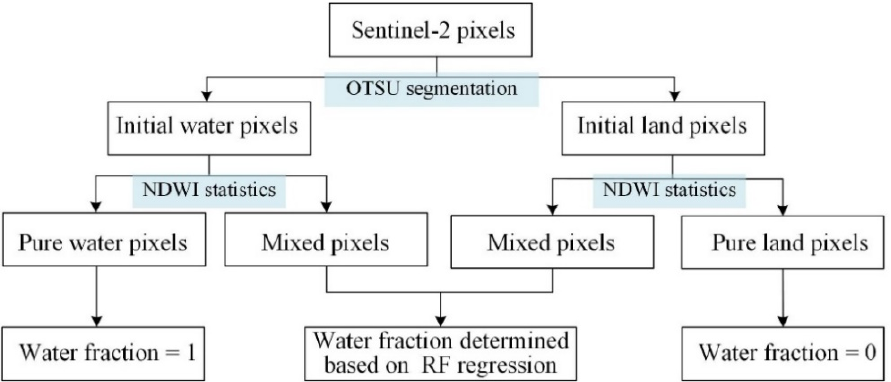
Figure 4. The hierarchical strategy of the proposed automated and hierarchical surface water fraction mapping (AHSWFM) method in mapping surface water fractions for pure and mixed pixels.